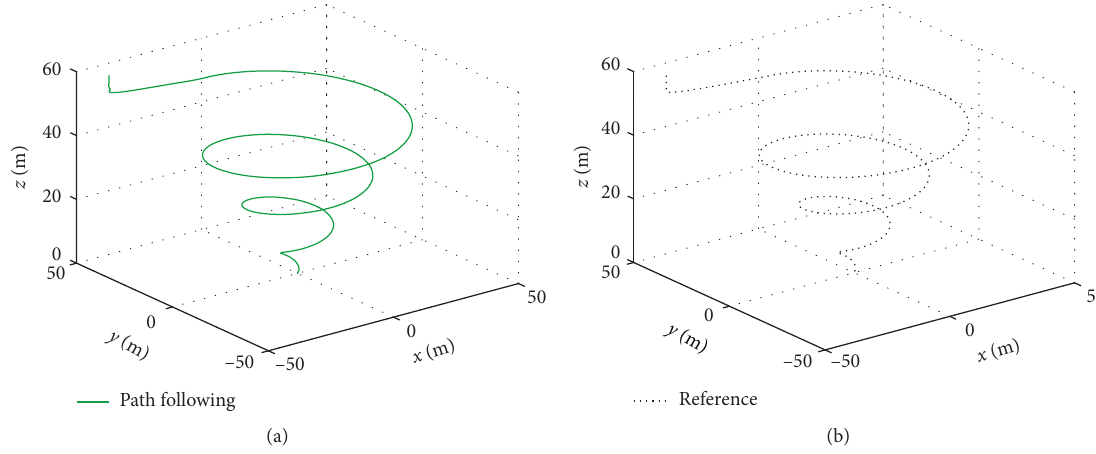
Figure 15: Satisfactory tracking of the reference path specified for the controlled quadrotor motion, case 3.